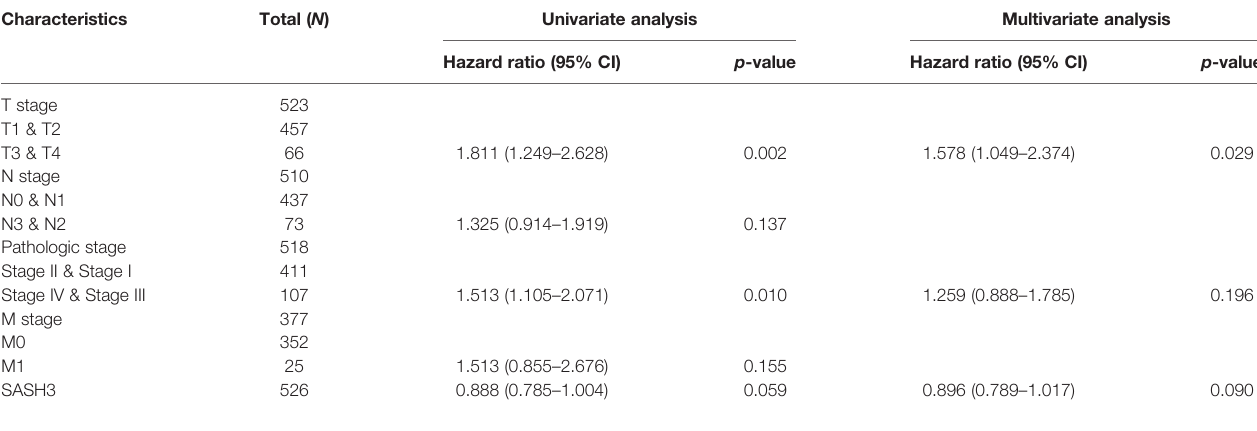
TABLE 3 | Univariate and multivariate Cox regression analyses of different parameters on disease-free survival in LUAD. Characteristics